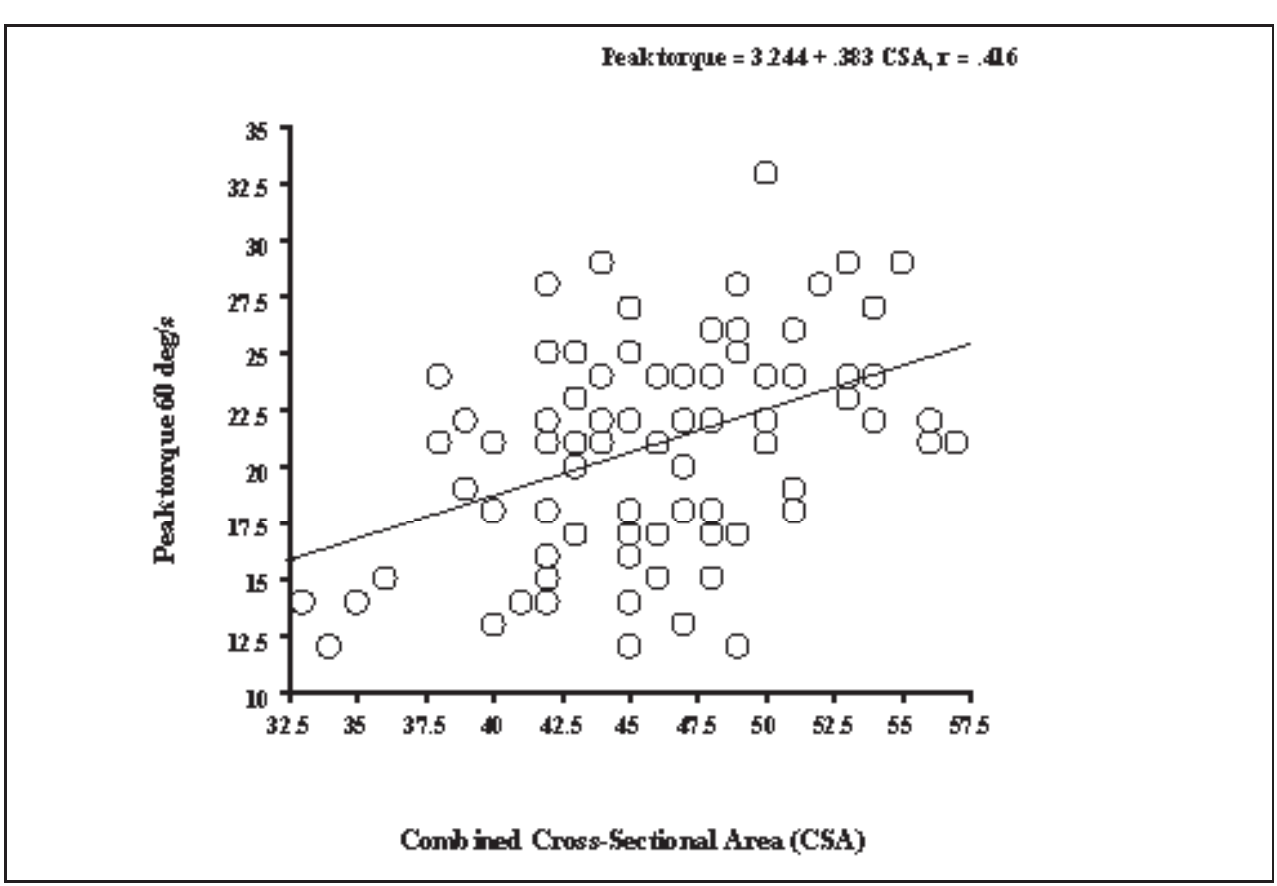
Fig. 4(A): Correlation between CSA and peak torque at 60 deg/s was less strong (A: 60 deg/s angular velocity, r = 0.416, p